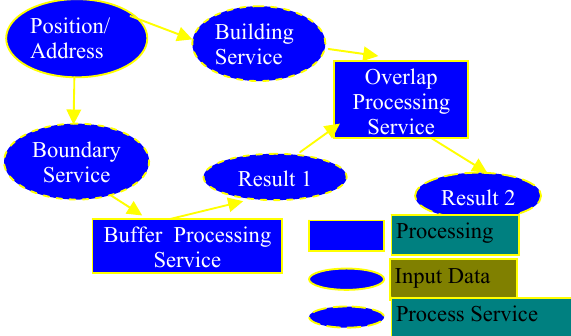
Figure 3. Conceptual business model of composition